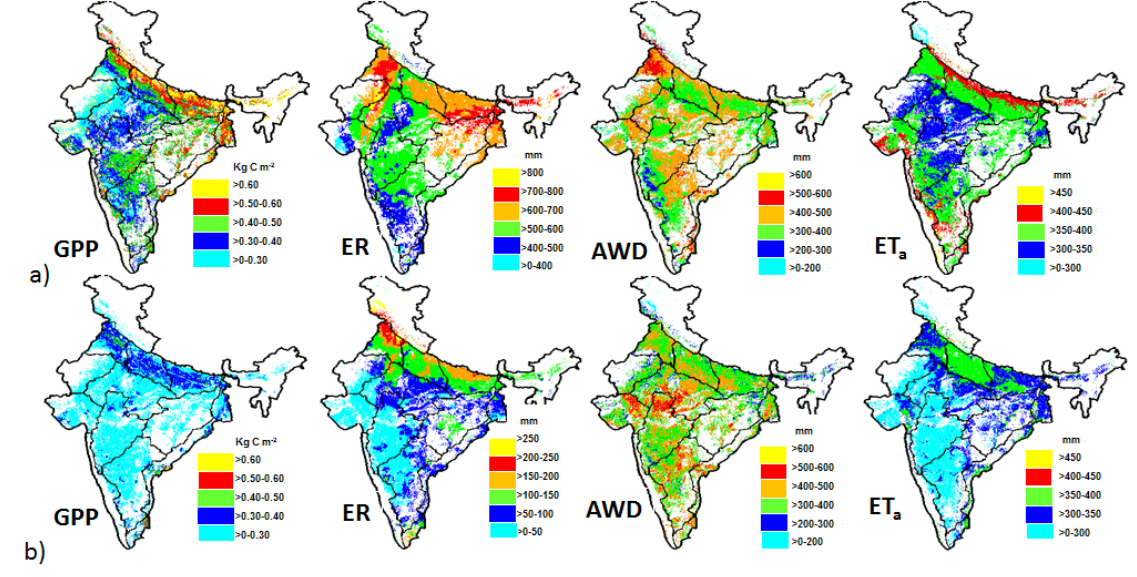
Figure 2: Spatial distribution of GPP, water availability and water usesover Indian regions,a) kharif; b) rabi season. The average agricultural productivity measured through GPP